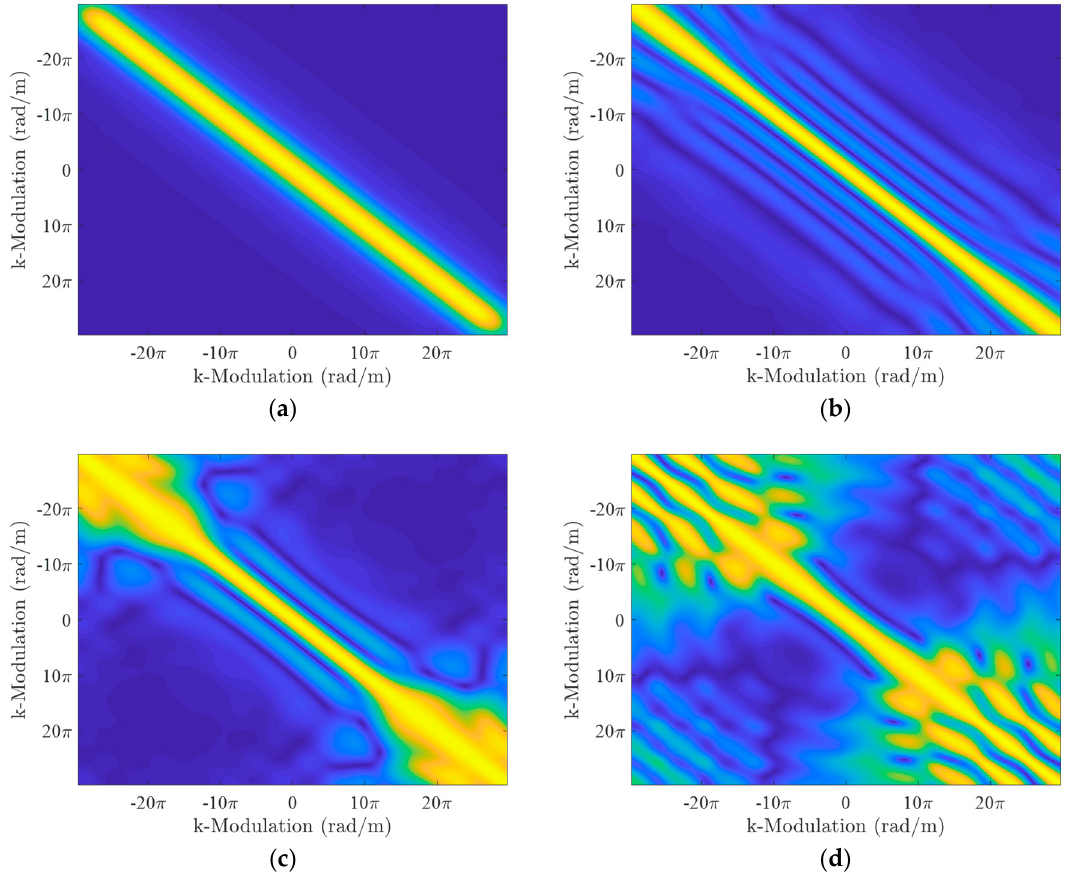
∗ | ∗ | and corresponding | ˆ H ˆ H at the imaging range of